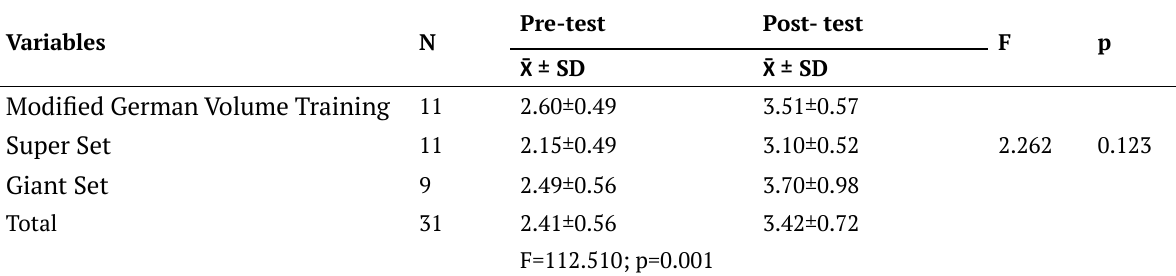
Table 3. Pre-test and post-test comparison of deltoid thickness values of the groups